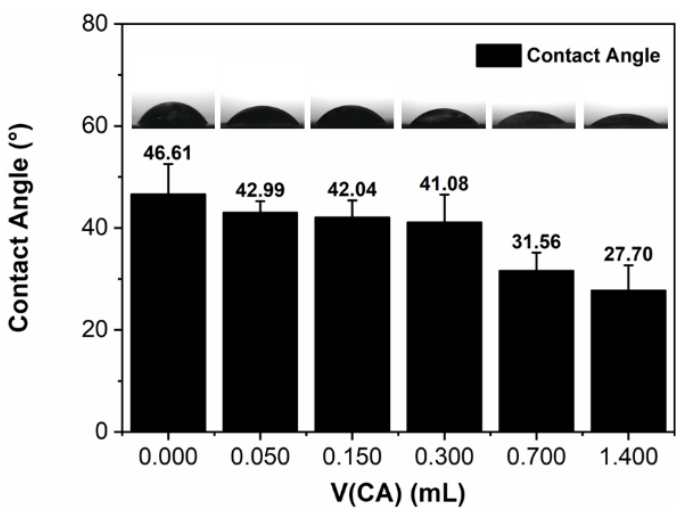
Figure 8. Water contact angle data for all CNF membranes with n = 3 and mean written above bars.